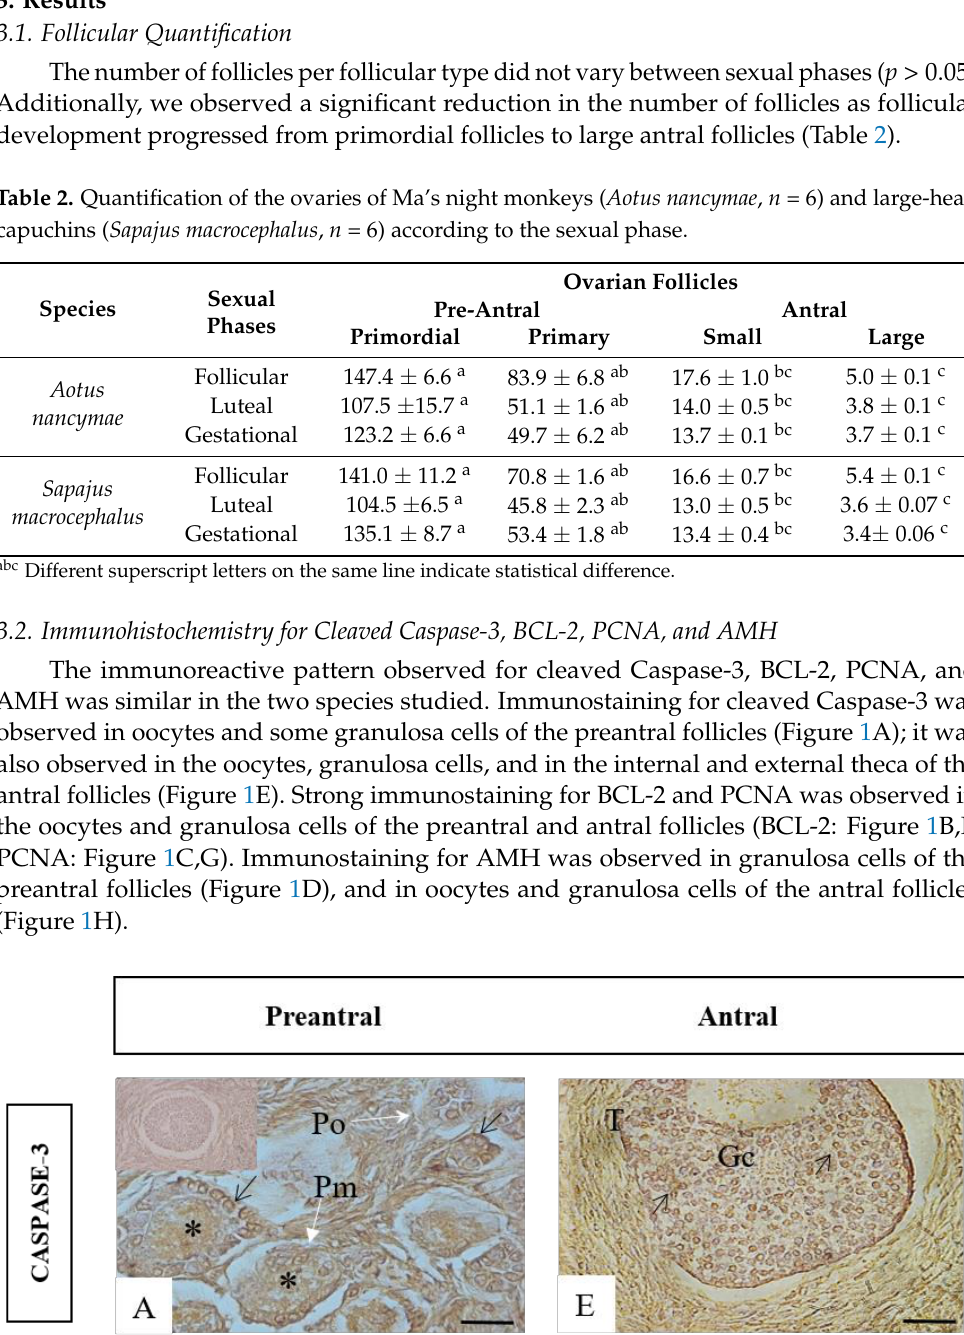
Figure 1. Photomicrographs of ovarian immunostaining for cleaved Caspase-3, BCL-2, PCNA, and AMH in granulosa cells and oocytes of the primordial and primary follicles ( A – D ) and small and large antral follicles ( E – H ) of Ma’s night monkey s ( Aotus nancymae ) and large-head capuchins ( Sap- ajus macrocephalus ). A: Negative control; Abbreviations: Po: Primordial follicle; Pm: Primary follicle; T: Theca layers; Gc: Granulosa cells; An: Antrum; *: oocytes. Arrow: immunostained granulosa cells. Hematoxylin – Eosin. Bar Scale: 25 µm. 3.3. Quantification of Immunolabeled Cells for Caspase-3-Cleaved, BCL-2, PCNA, and AMH We observed significant differences in the quantification of immunostained cells in the ovarian follicles of both species according to the sexual phase ( p < 0.05). Immunostain- ing for Caspase-3 and AMH in oocytes, granulosa cells, preantral and antral follicles was higher in females in the follicular phase. Immunostaining for BCL-2 and PCNA was mostly higher in females in the follicular phase ( p < 0.05); Table 3 shows these differences according to cell type and the NPH.